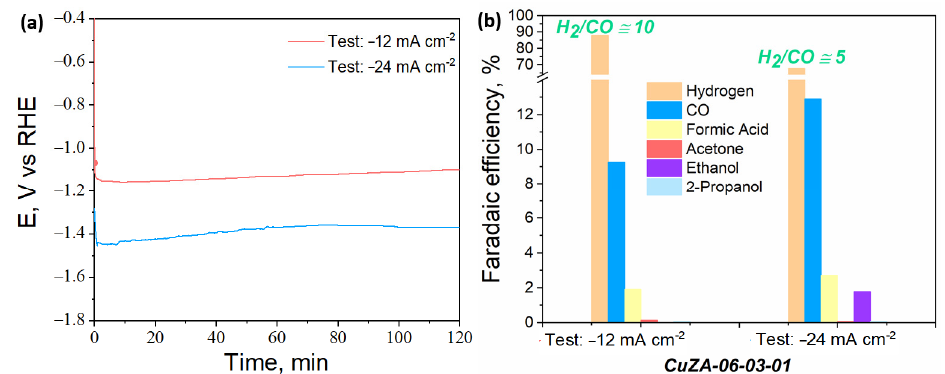
Figure 14. ( a ) Time evolution of the cathodic potential and ( b ) Faradaic efficiencies for the ER-CO 2 on the CuZA-06-03-01 GDEs tested at − 12 and − 24 mA cm − 2